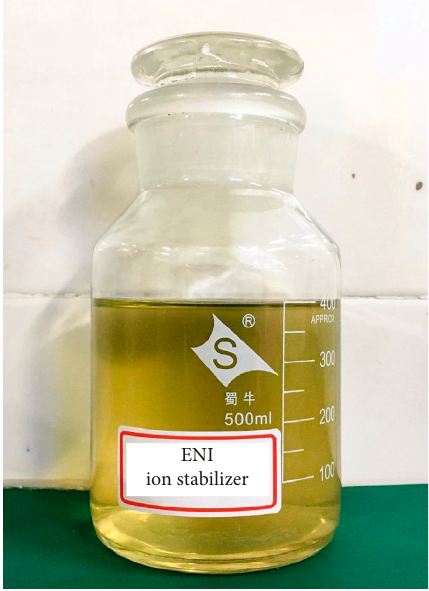
Figure 1: The actual picture of ENI ion stabilizer.